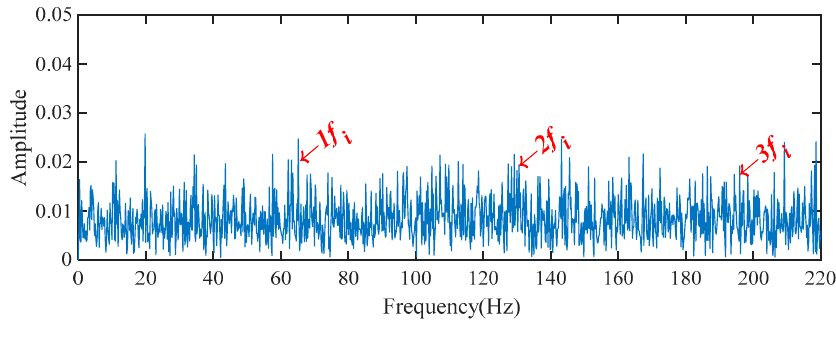
Figure 8. The spectrum of the WAEEMD filtered signal.